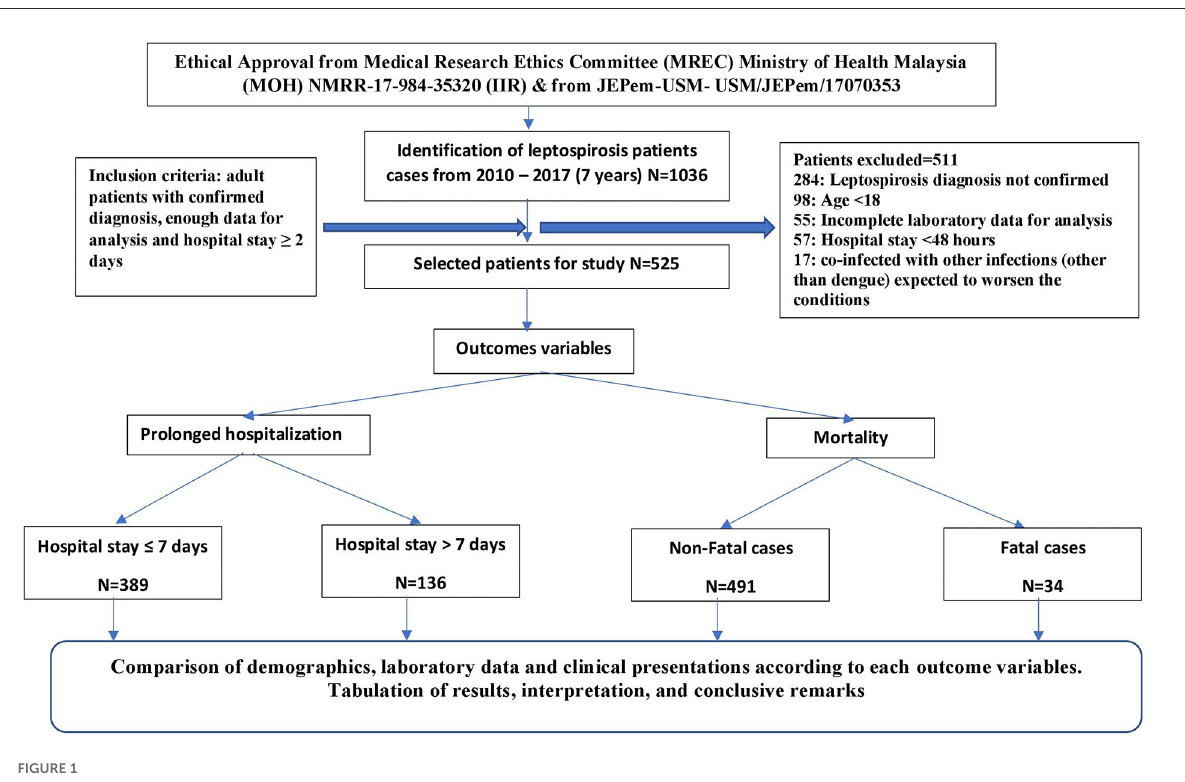
FIGURE1 Study flow